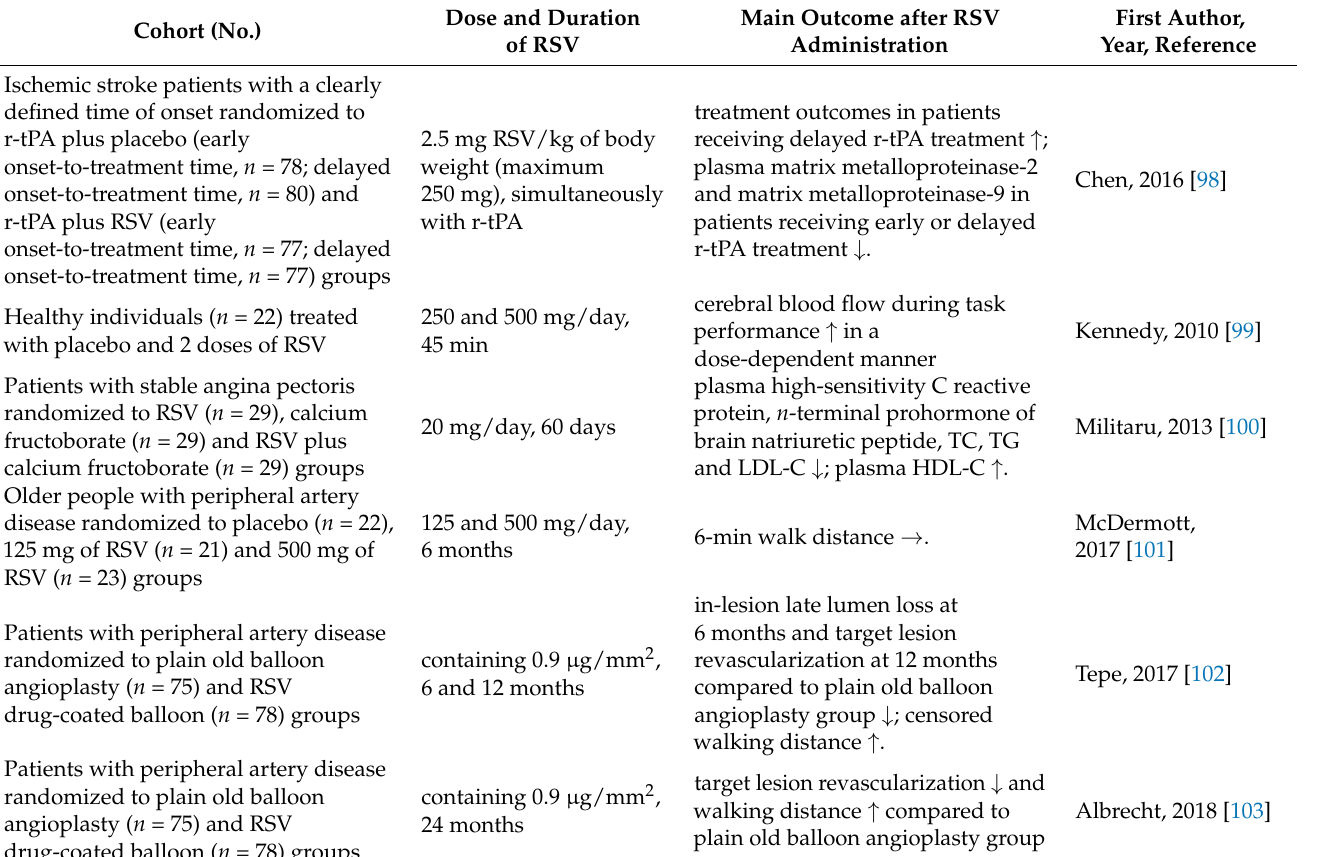
Table 3. Summary of clinical trials involving the use of RSV in